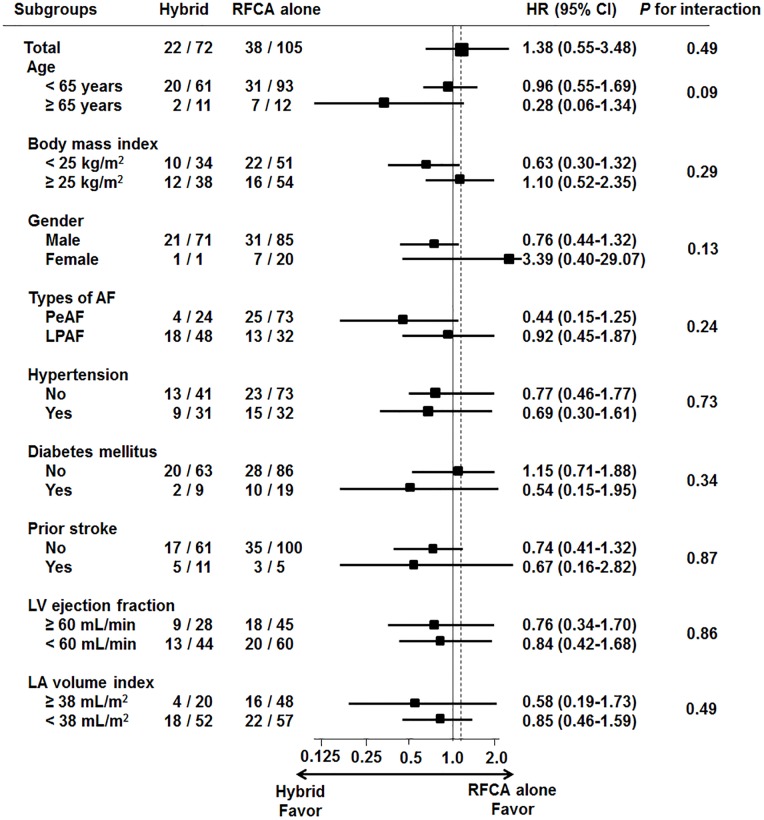
Subgroup analysis for total atrial arrhythmia.AF, atrial fibrillation; HR, hazard ratio; LA, left atrium; LV, left ventricle; PeAF, persistent atrial fibrillation; LSPF, longstanding-persistent atrial fibrillation; RFCA, radiofrequency catheter ablation.